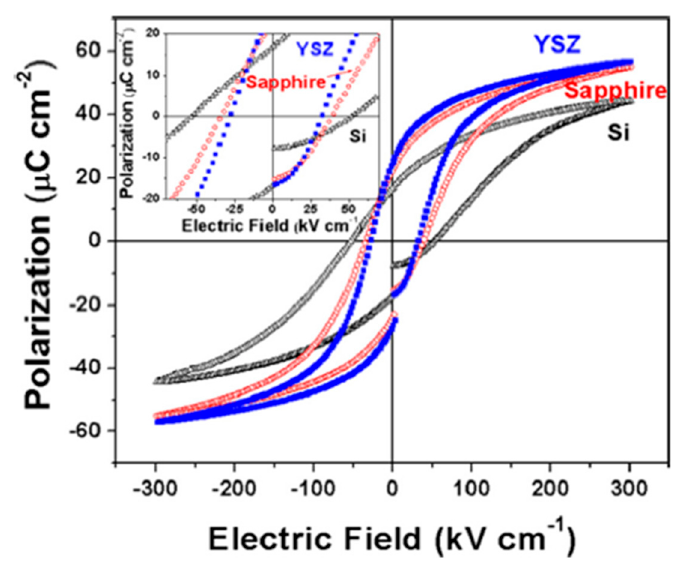
Figure 9. P - E hysteresis loops of annealed PZT films deposited on different substrates [26]. © Copyright 2011, J. Appl. Phys.